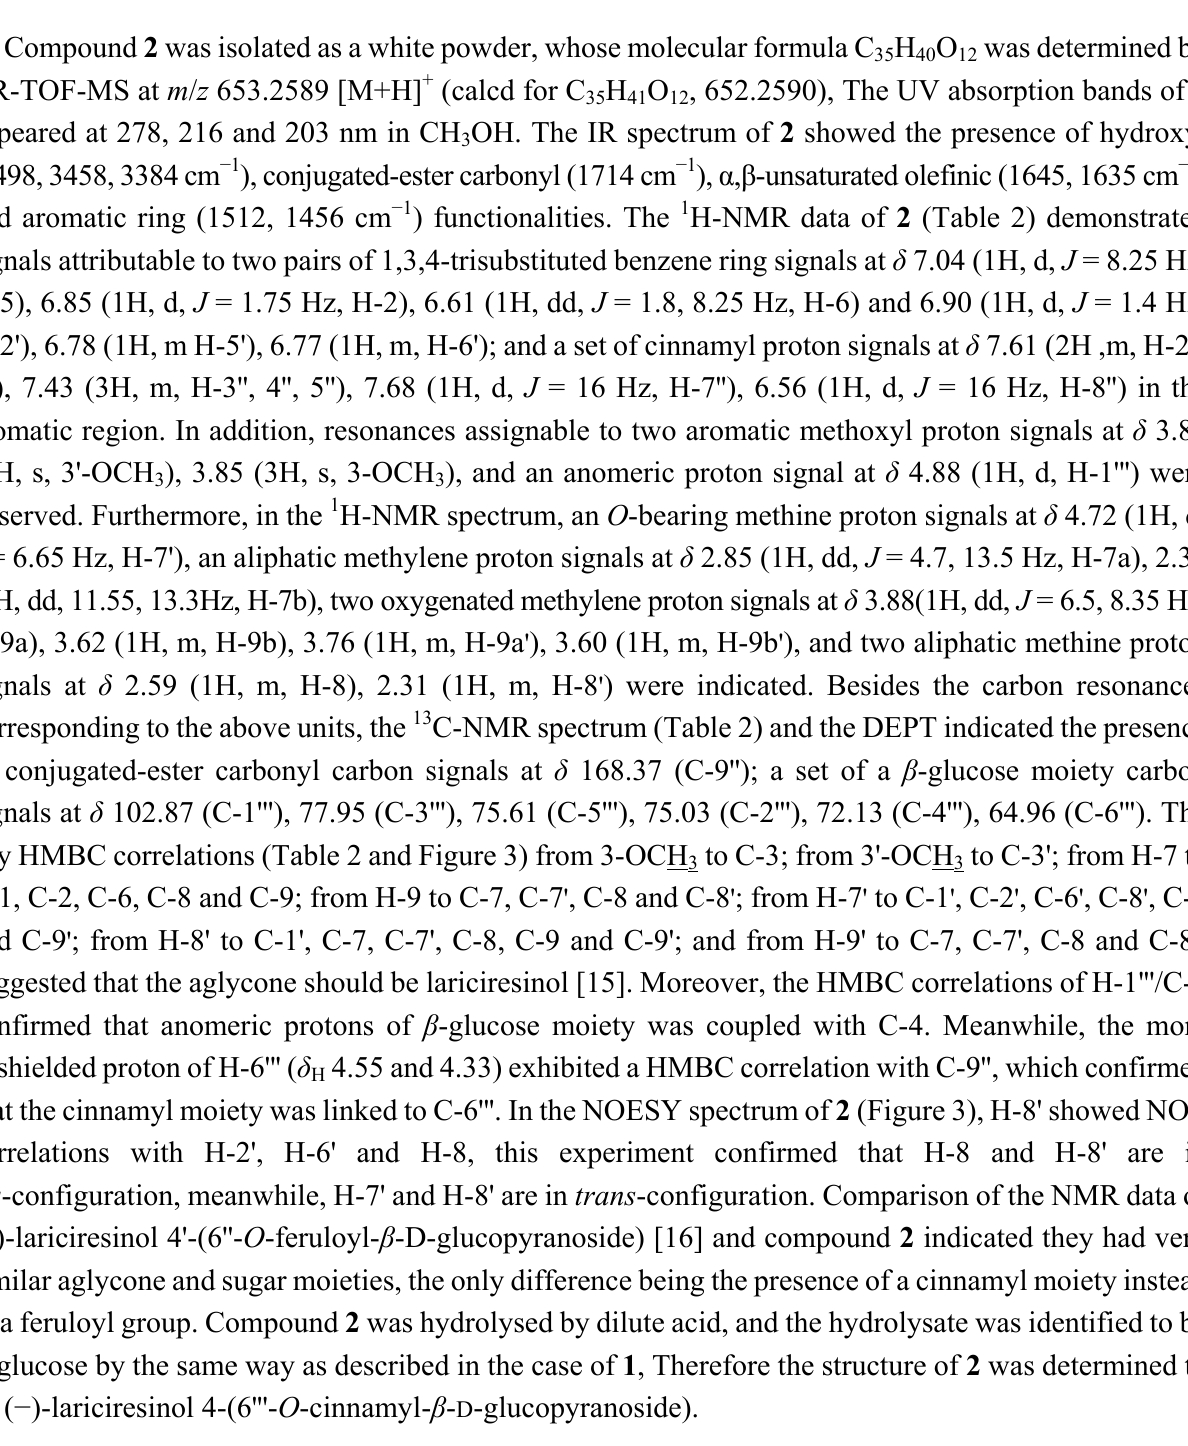
Figure 3. Key HMBC and NOESY correlations in compound 2